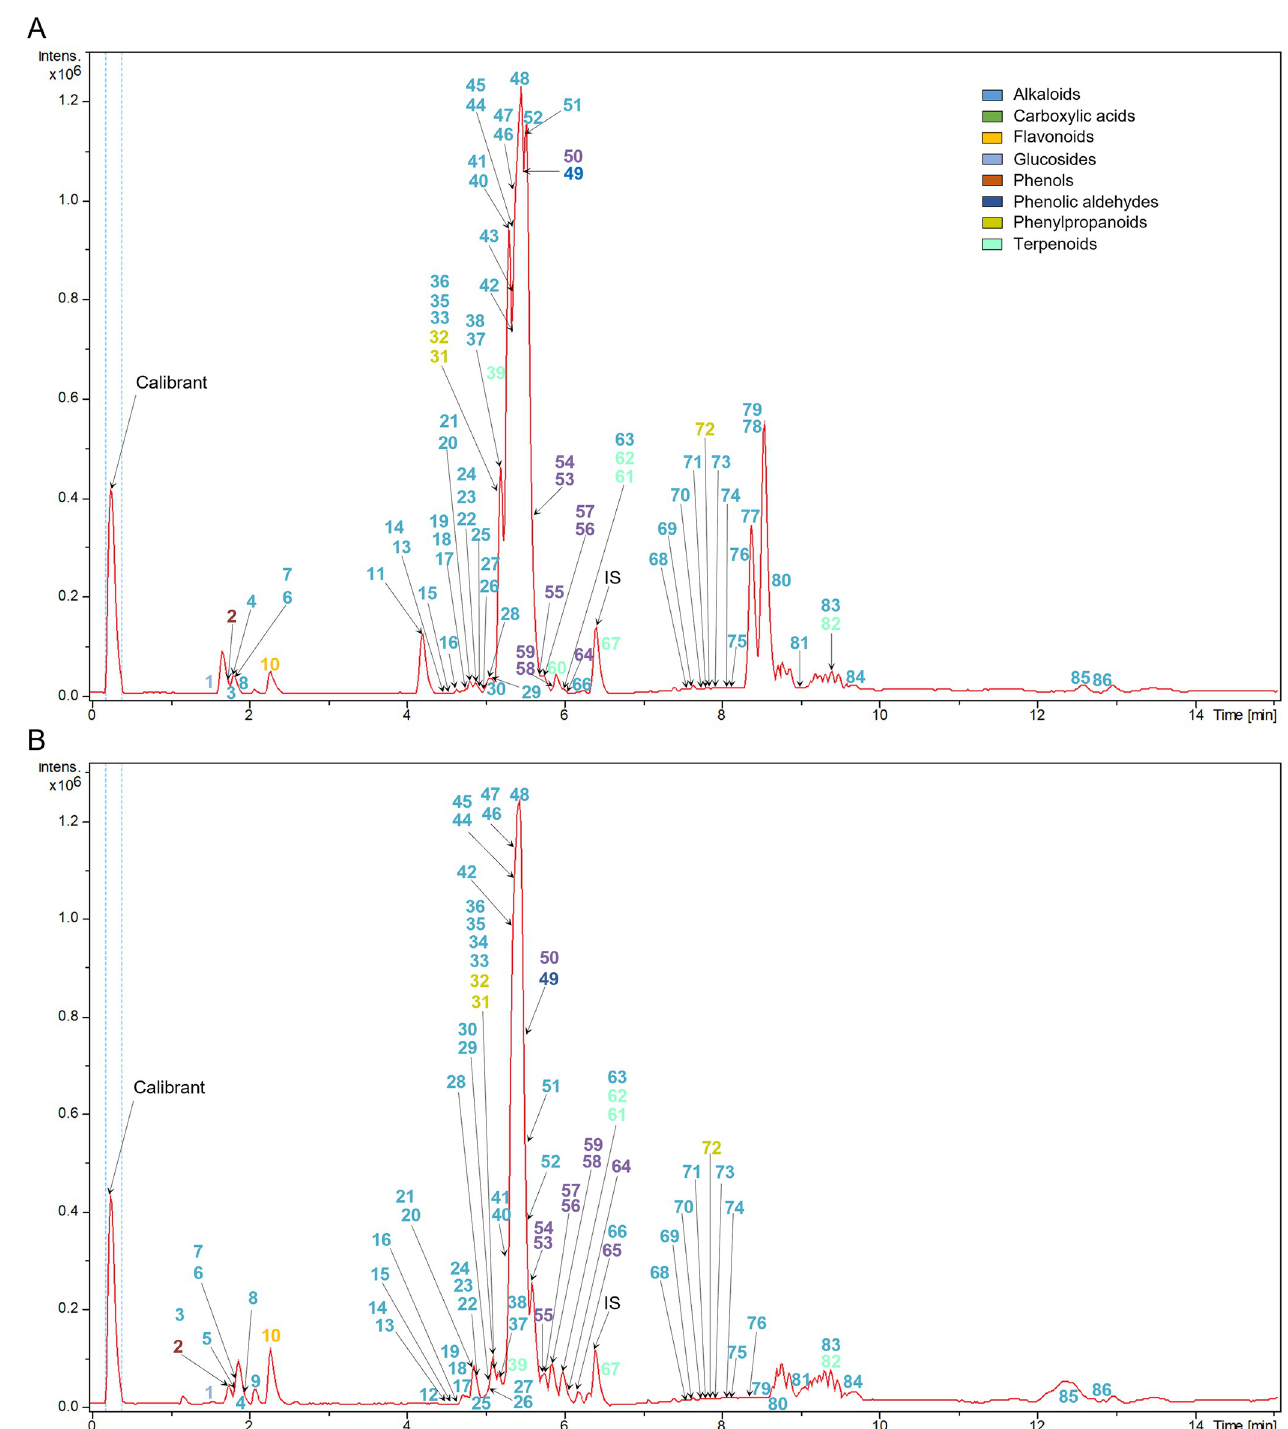
Fig 1. The representative base peak chromatograms (BPC) of young (A) and mature (B) M . speciosa leaf methanol extract obtained by LC-ESI-TOF-MS. Peak numbering designates the identified compounds.